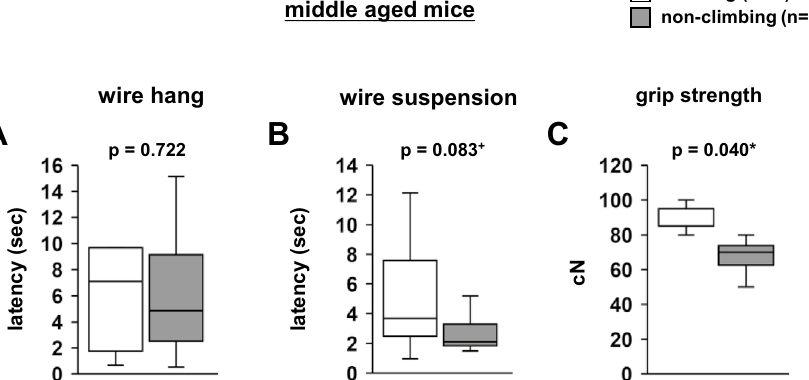
Figure 9. The effect of grid-climbing prevention on physical characteristics in middle age. The latency to fall in the wire hang test ( A ) and wire suspension test ( B ), and grip strength test ( C ). Data are presented as box plots ( A – C ). Statistical significance is represented by asterisks: * p < 0.05, + p < 0.1. P -values were calculated using the one-way analysis of variance ( A – C ). ( A – C ) climbing: n = 15; non-climbing: n = 15.